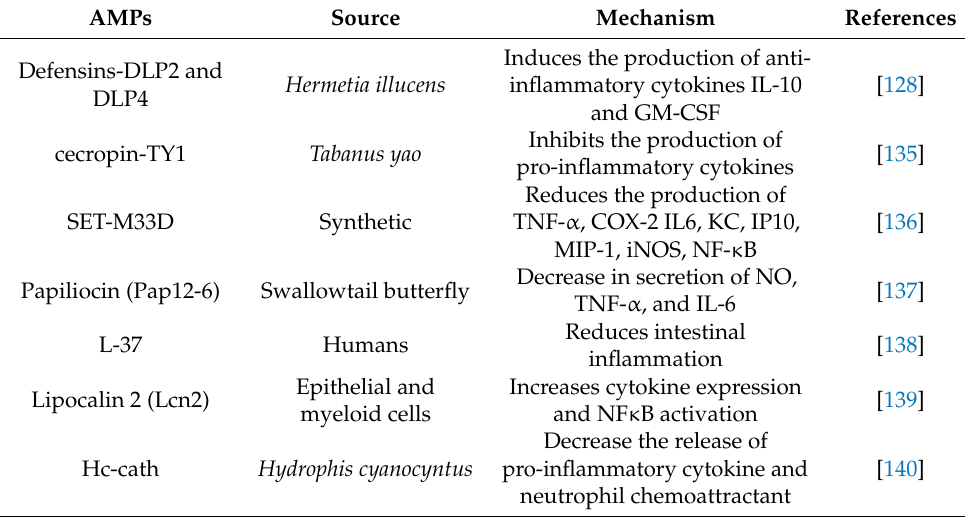
Table 7. List of some of the AMPs suggesting an anti-inflammatory effect.